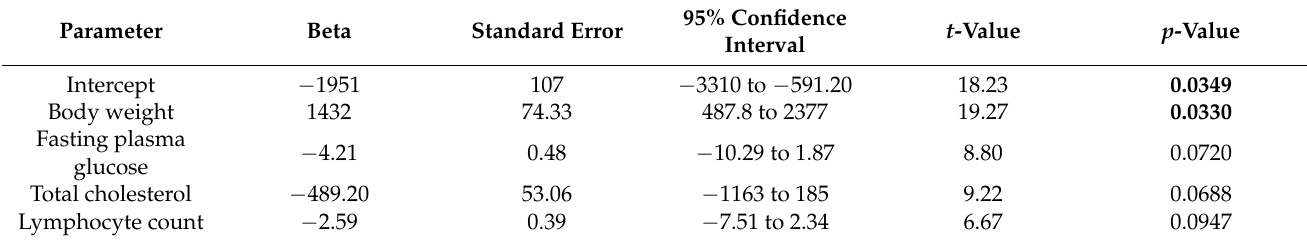
Table 2. A multivariable logistic regression of the potential modifiers of Fas expression in T-cells.